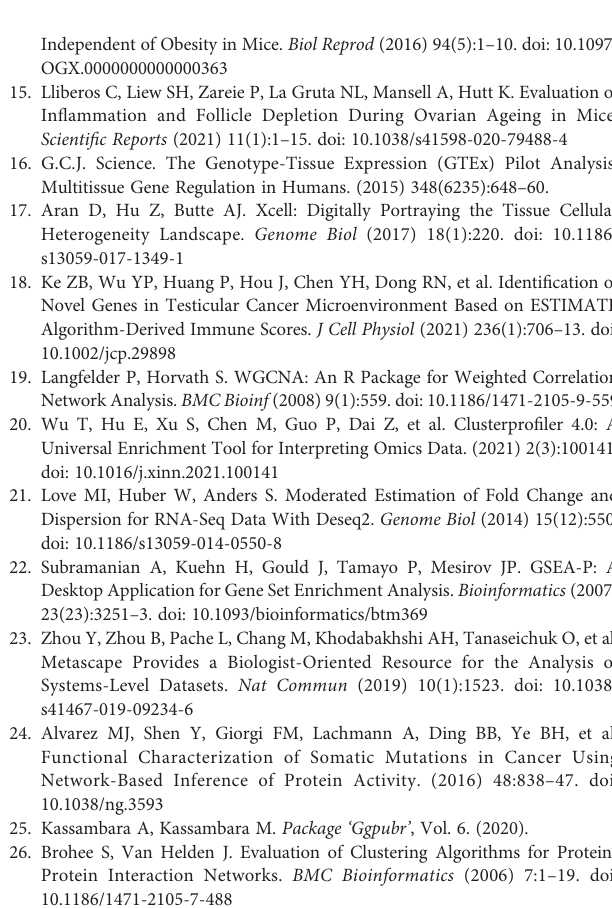
Supplementary Figure 1 | No signi fi cant differences in mitochondria-related genes between the 20-39 and 30-39 age groups. Supplementary Figure 2 | Differentially expressed genes for diagnosis of ovarian senescence in women of reproductive